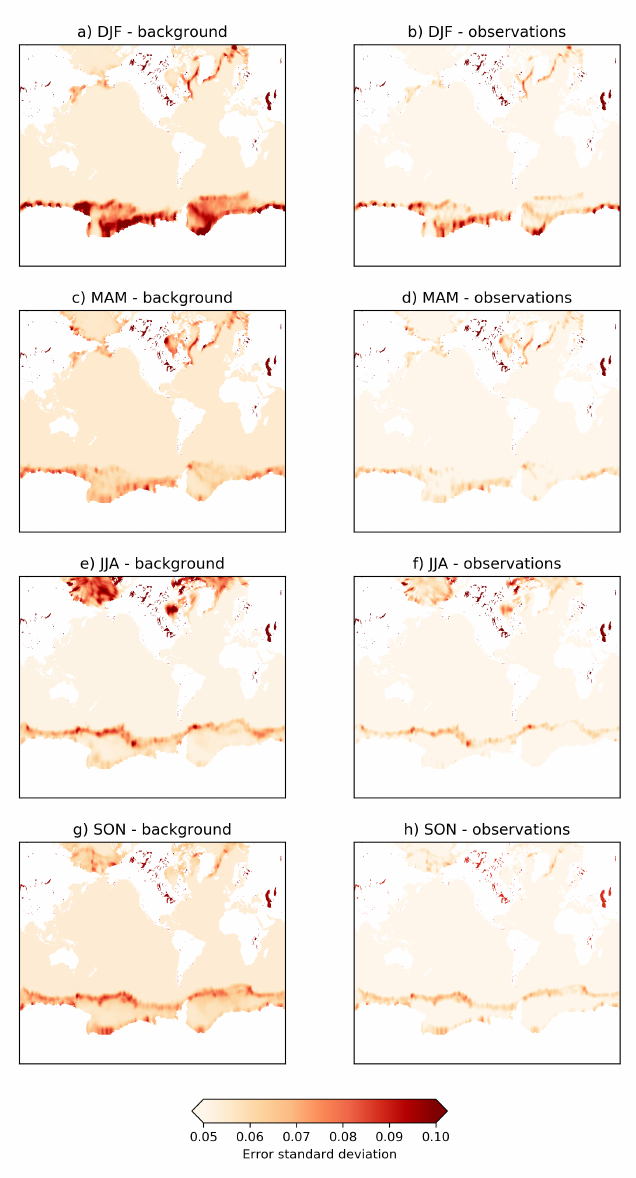
Figure 3. Error standard deviations used for the IC analysis for ( a ) the background in the December-January-February season and ( b ) the observations during the same season. ( c , d ): as ( a , b ) expect for March-April-May; ( e , f ): June-July-August; and ( g , h ):